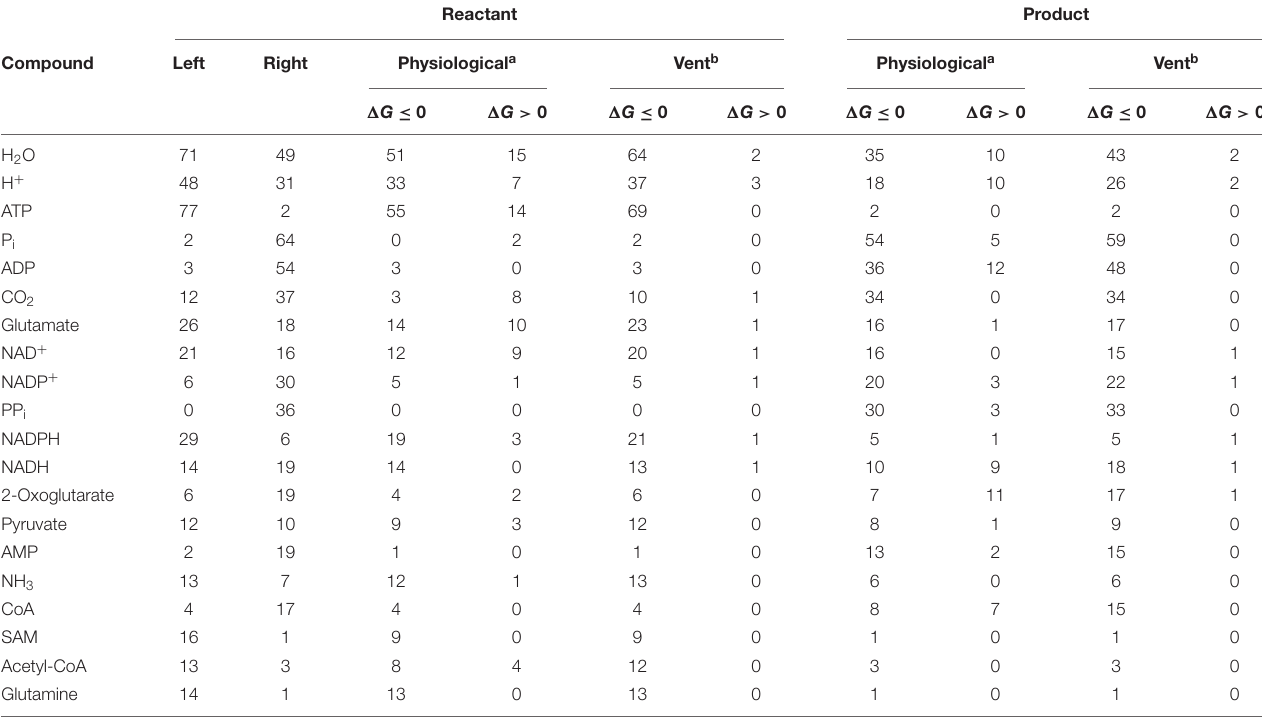
TABLE 1 | Most frequent reactants and products in the